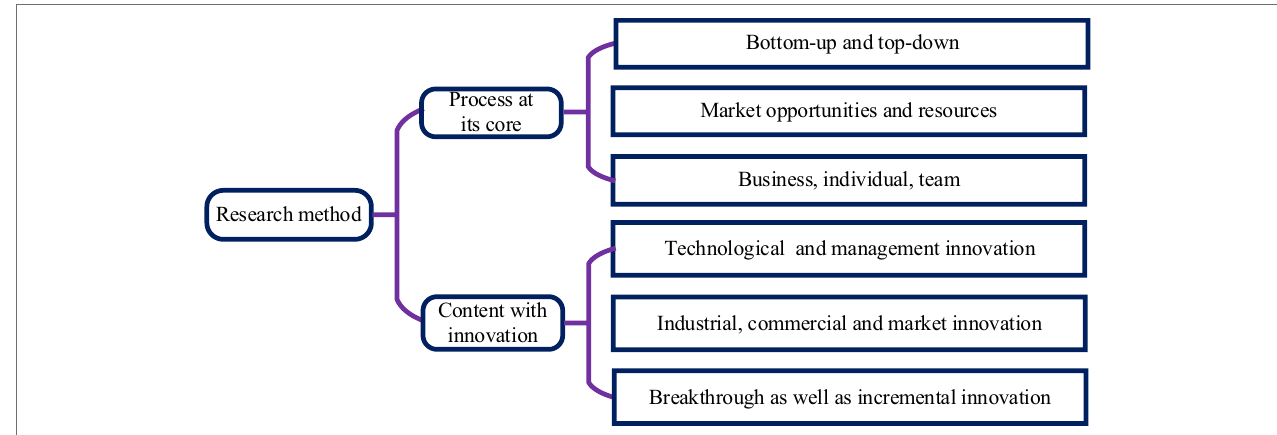
FIGURE 2 | The specific connotation of innovative research